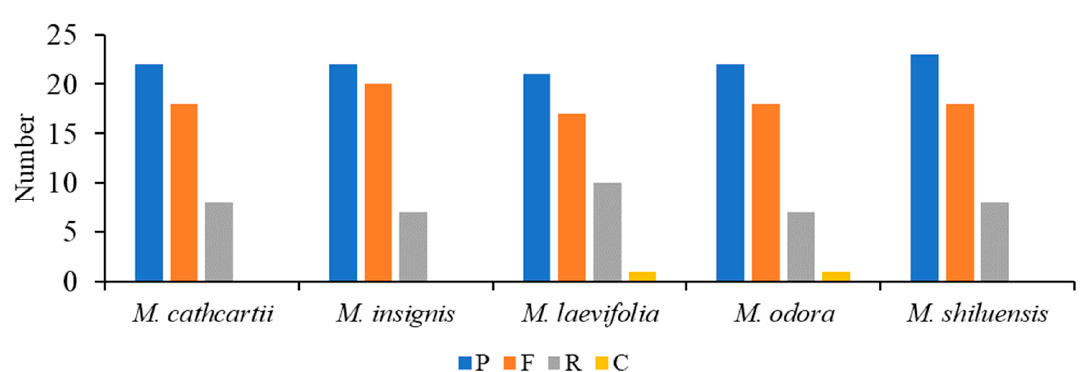
Figure 2. Comparison of repeats among five Magnoliaceae species: Michelia shiluensis , Michelia odora , Magnolia laevifolia , Magnolia insignis , and Magnolia cathcartii . (F: Forward; R: Reverse; C: Complement; and P: Palindromic).